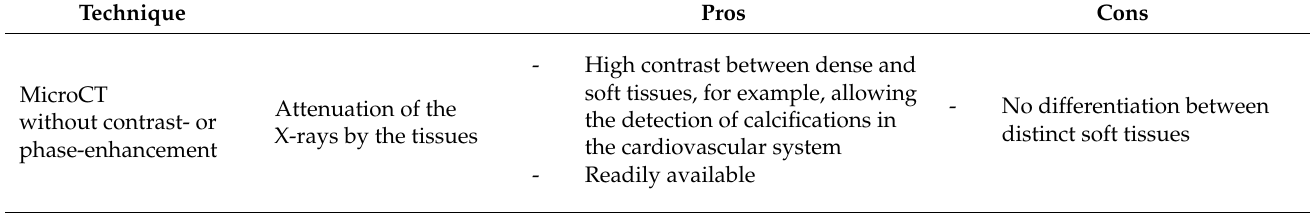
Table 1. Pros and cons of X-ray microfocus computed tomography (microCT)-based imaging techniques for biological tissues. CAs: contrasting agents, CESAs: contrast-enhancing staining agents and CCA: casting contrast agent.